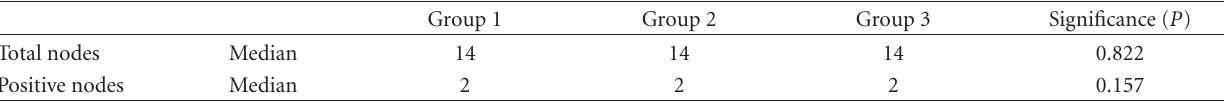
Table 2: Outcome Measures. Group classification of patients by axillary procedure: group 1: primary axillary clearance; group 2: SLNB and dALND; group 3: SLNB and